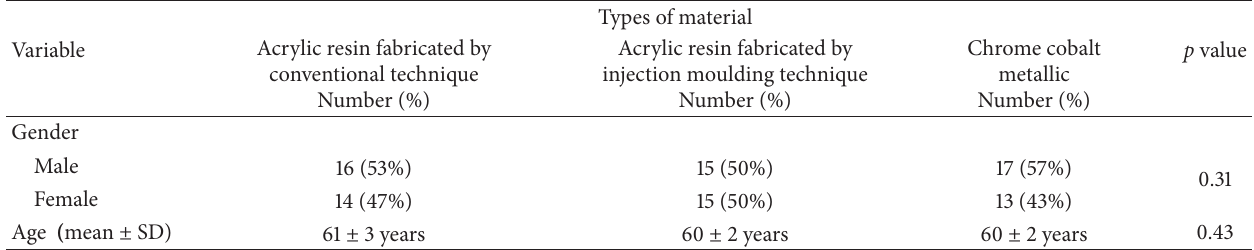
Table 1: Demographic characteristics of the patients that took part in the